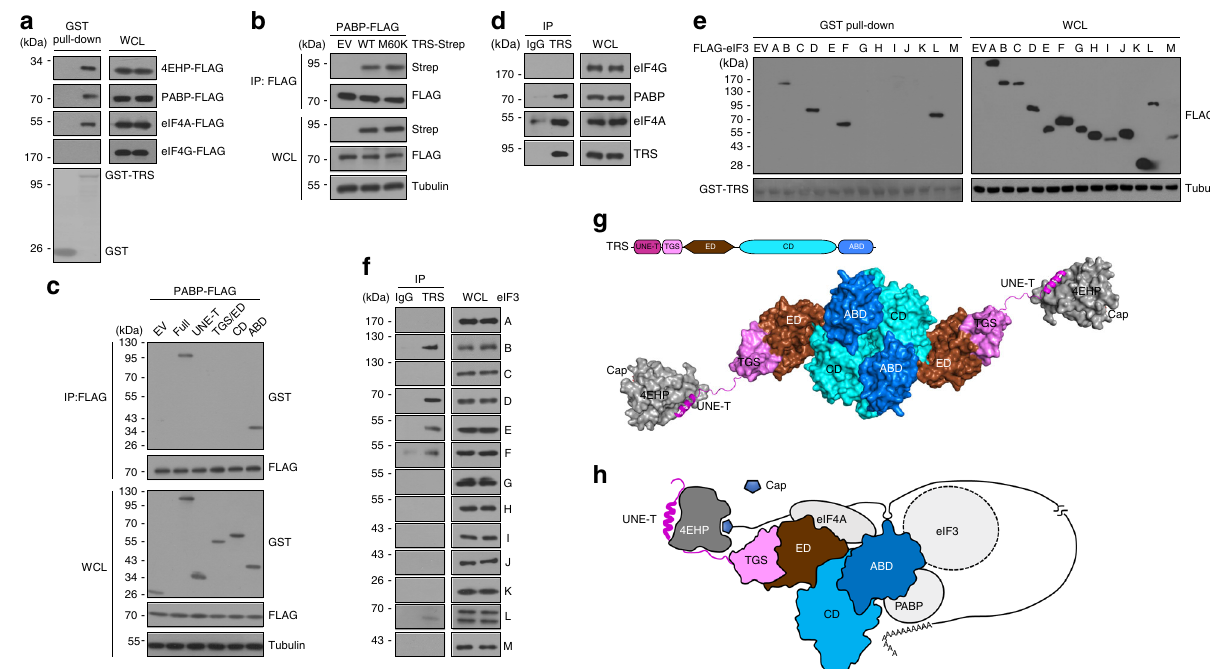
Fig. 7 Discovery of a TRS-mediated translation initiation machinery. a Pull-down assay of GST-TRS with FLAG-tagged proteins. Puri fi ed GST-TRS from E. coli was incubated with 293T cell lysates with FLAG-tagged 4EHP, PABP, eIF4A, or eIF4G. GST-TRS was pulled down with glutathione-Sepharose beads, and co-precipitation of each FLAG-tagged protein was determined by immunoblotting with anti-FLAG antibody. b Immunoassay of co-expressed PABP- FLAG with WT or M60K mutant TRS-Strep in 293T cells. PABP-FLAG was immunoprecipitated with anti-FLAG antibody, and co-precipitated TRS proteins were determined by immunoblotting with anti-Strep antibody. c Immunoassay of co-expressed PABP-FLAG with GST-fused full-length TRS or its various domains in 293T cells. PABP-FLAG was immunoprecipitated with anti-FLAG antibody, and co-precipitated TRS proteins were determined by immunoblotting with anti-GST antibody. d Endogenous TRS was immunoprecipitated from WI-26 cells with a mouse anti-TRS antibody, and co- immunoprecipitates were examined with the indicated antibodies. Mouse IgG was used as a negative control. e Pull-down assay of GST-TRS with FLAG- tagged eIF3 subunits. Puri fi ed GST-TRS from E. coli was incubated with 293T cell lysates containing each of the FLAG-tagged eIF3 subunits. GST-TRS was pulled down with glutathione-Sepharose beads, and co-precipitation of each FLAG-tagged protein was determined by immunoblotting. f Endogenous TRS was immunoprecipitated from WI-26 cells with a mouse anti-TRS antibody, and co-immunoprecipitates were examined with the indicated antibodies. Mouse IgG was used as a negative control. Data are representative of at least three experiments, each with similar results ( a − f ). g Structural model showing the interaction of 4EHP with the UNE-T region of the TRS dimer. Each domain of TRS is labeled as in Fig. 1f. A monomer of TRS is shown in surface representation, and the UNE-T regions interacting with both 4EHP molecules are shown in cartoon representation. The model was built based on the crystal structure (PDB 1QF6) of E. coli TRS 56 . h Schematic model of the TRS-mediated translation initiation machinery. See the main text for a full description. Although TRS is predicted to function as a homodimer, the model only shows the monomer for simplicity. eIF3 is depicted by a dotted